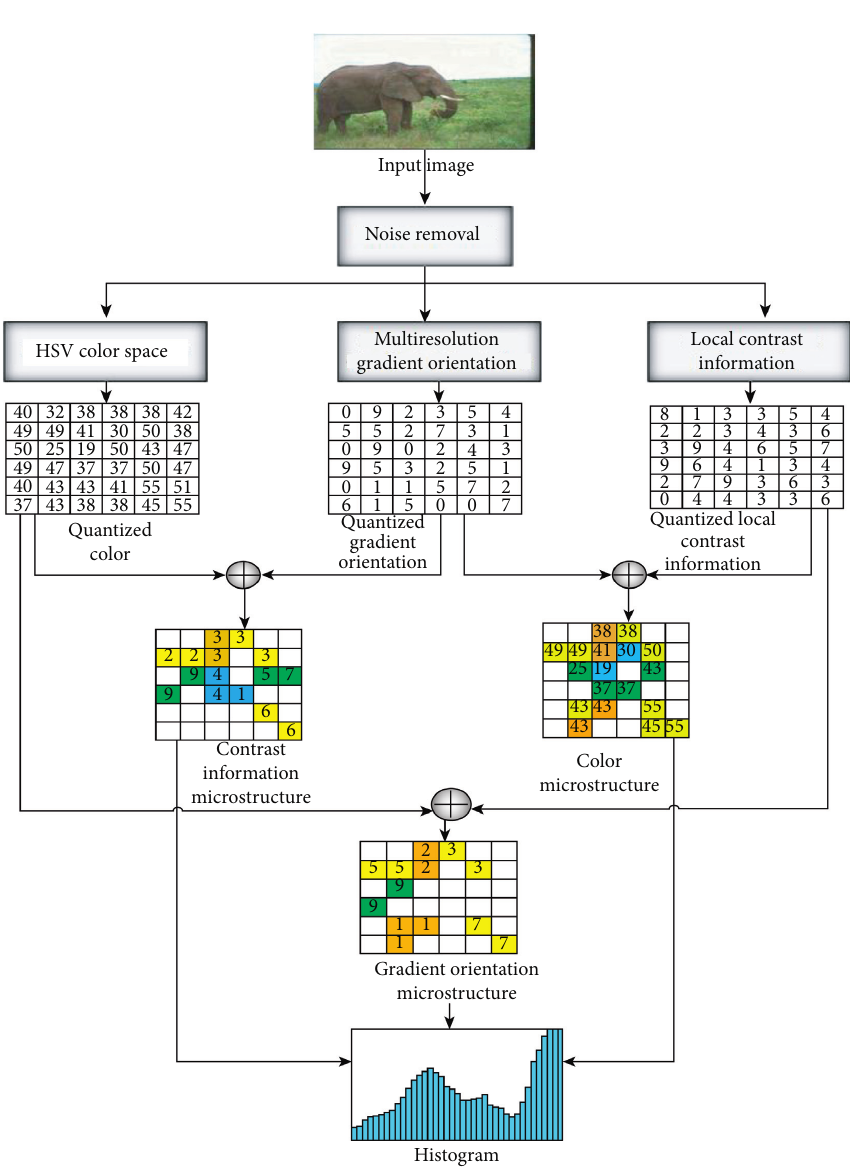
Figure 2: Visual representation of proposed NRLGO descriptor for CBIR system. The proposed NRLGO consists of three steps: estimation and removal of noise to protect the local visual structure; then the color and texture feature extraction; and, at the end, microstructure